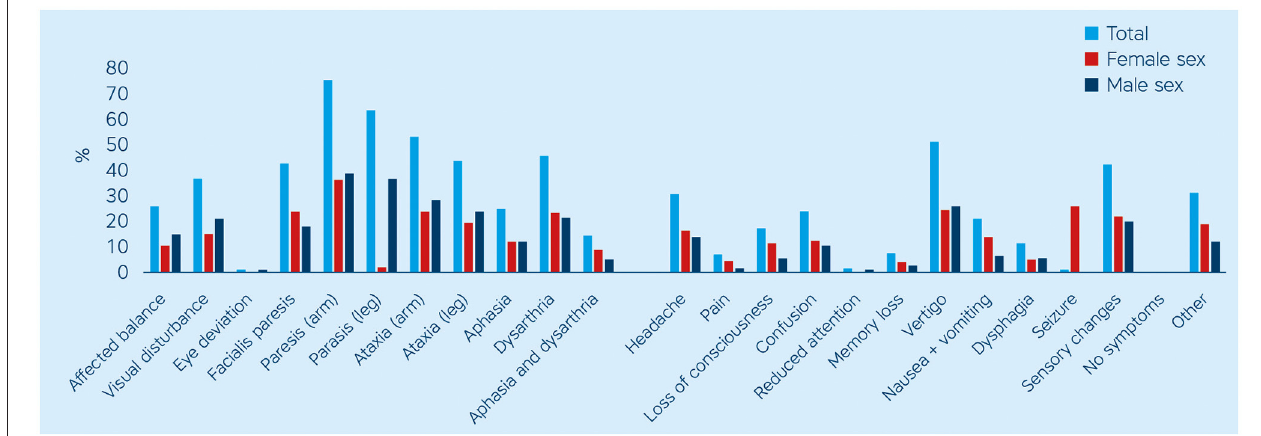
FIGURE 1 | Acute patient-reported typical and atypical stroke symptoms,